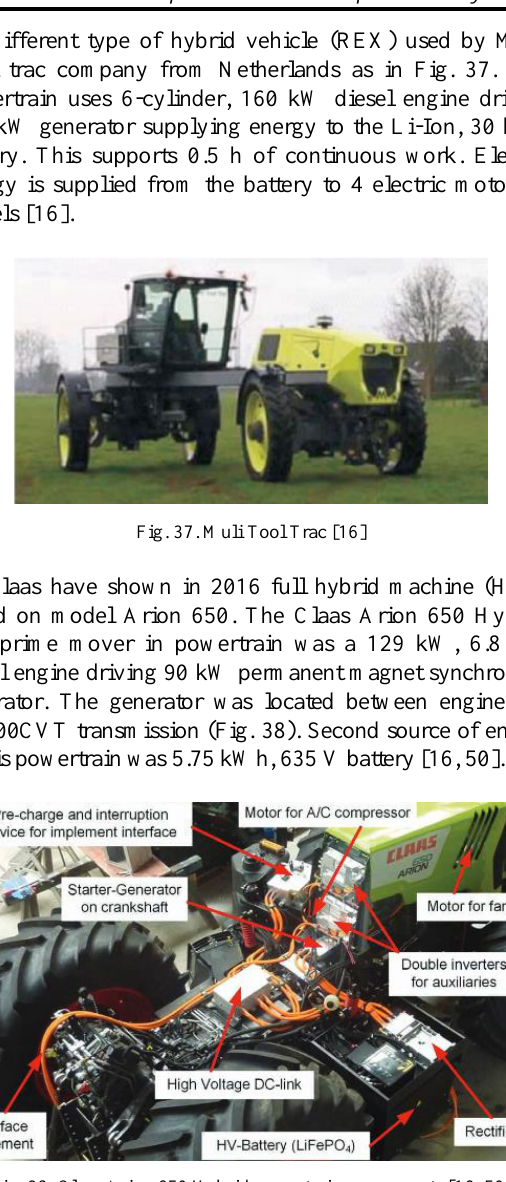
Fig. 38. Class Arion 650 Hybrid powertrain components [16, 50]